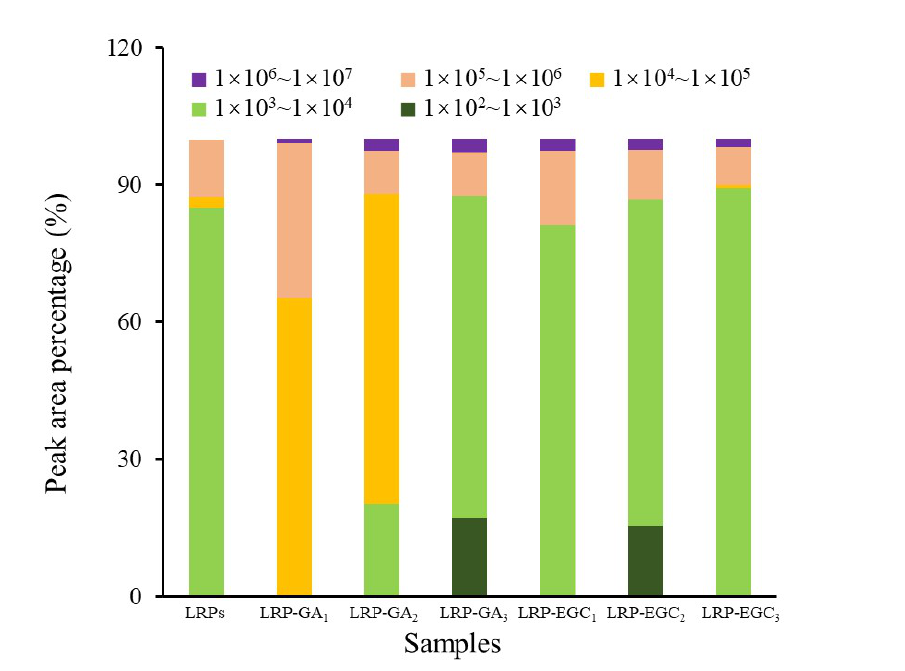
Figure 6. The peak area percentage of fractions with different molecular weights from LRPs and LRP-phenol